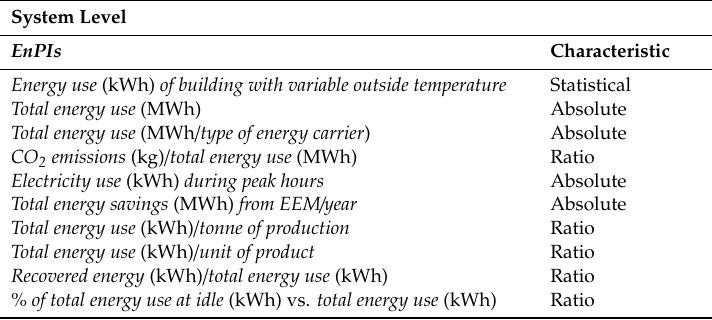
Table 5. EnPIs identified for system level for the engineering industry.